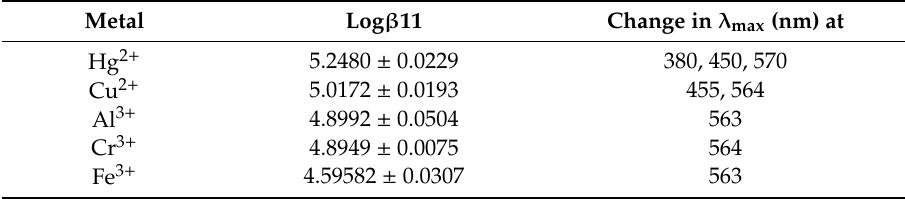
Figure 10. A correlation between the observed absorbance and absorbance value calculated using the HypSpec program for a titration between 1 and Hg 2 + ions with 1:1 (H:G) binding stoichiometry. Table 3. The binding constant value obtained for a 1:1 (H:G) binding stoichiometry and changes observed at a di ff erent wavelength for 1 with di ff erent metal